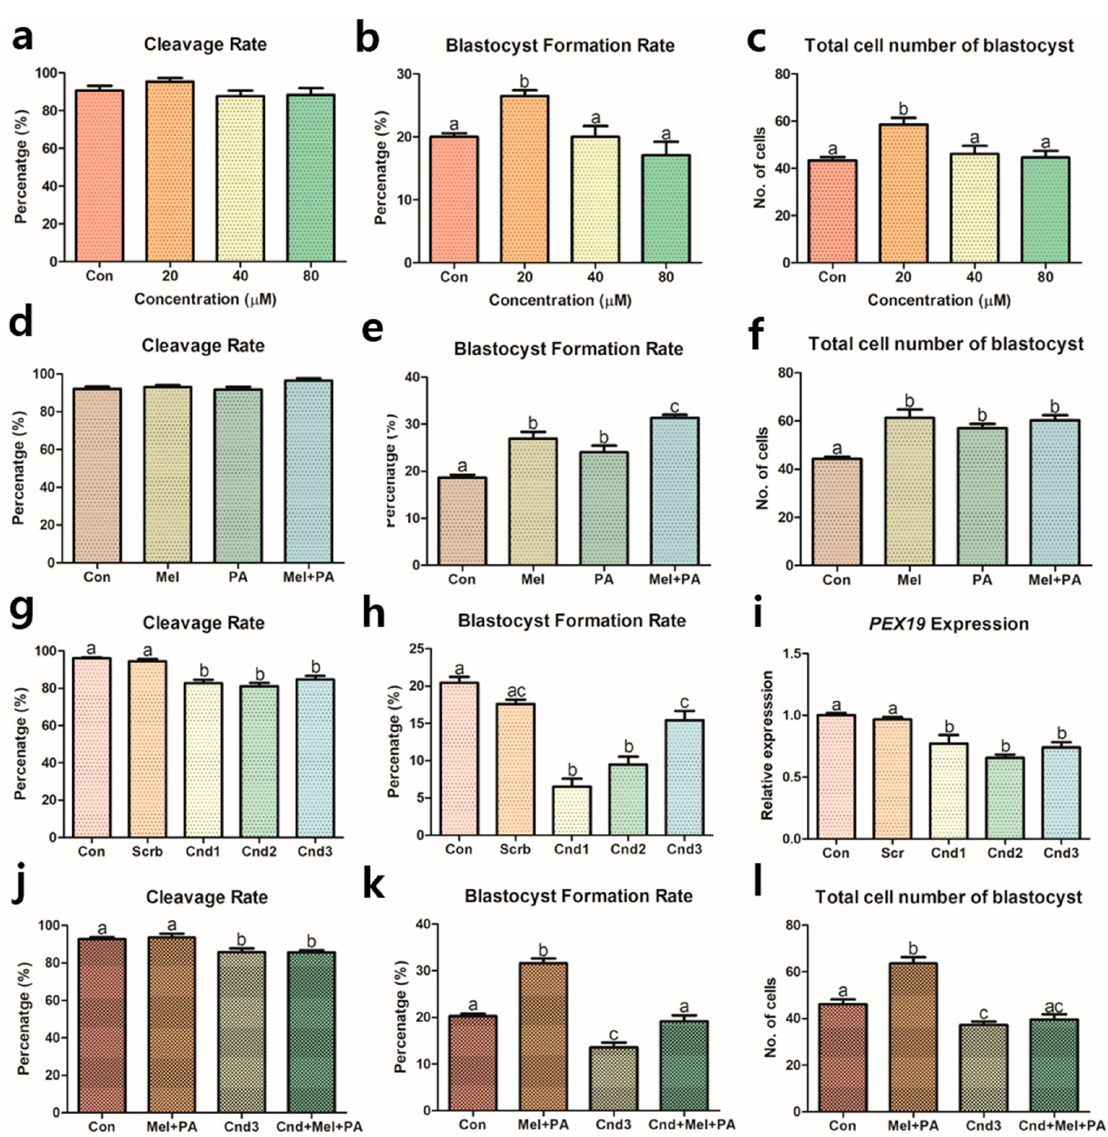
Figure 1. Assessments of porcine embryonic development treated with melatonin and phytanic acid (PA), and injected with Pex19 -targeted siRNAs. ( a – c ) Optimization of PA during porcine IVC through rates of cleavage, blastocyst formation, and total cell numbers of blastocysts. ( d – f ) Assessment of co-treatment effect by melatonin and PA. ( g , h ) Selection of Pex19 -targeted siRNAs through embryonic development and ( i ) verification of Pex19 knockdown by real-time PCR. ( j – l ) Assessment of melatonin/PA treatment and siRNA on porcine embryos through rates of cleavage, blastocyst formation, and total cell numbers of blastocysts. At least five biological replications were performed and more than 170 embryos from each experimental group were used. Data are shown as the means ± SEM. Groups marked with different alphabetical letters are significantly different ( p < 0.05). Con, control; mel, melatonin; PA, phytanic acid; Cnd, candidate.